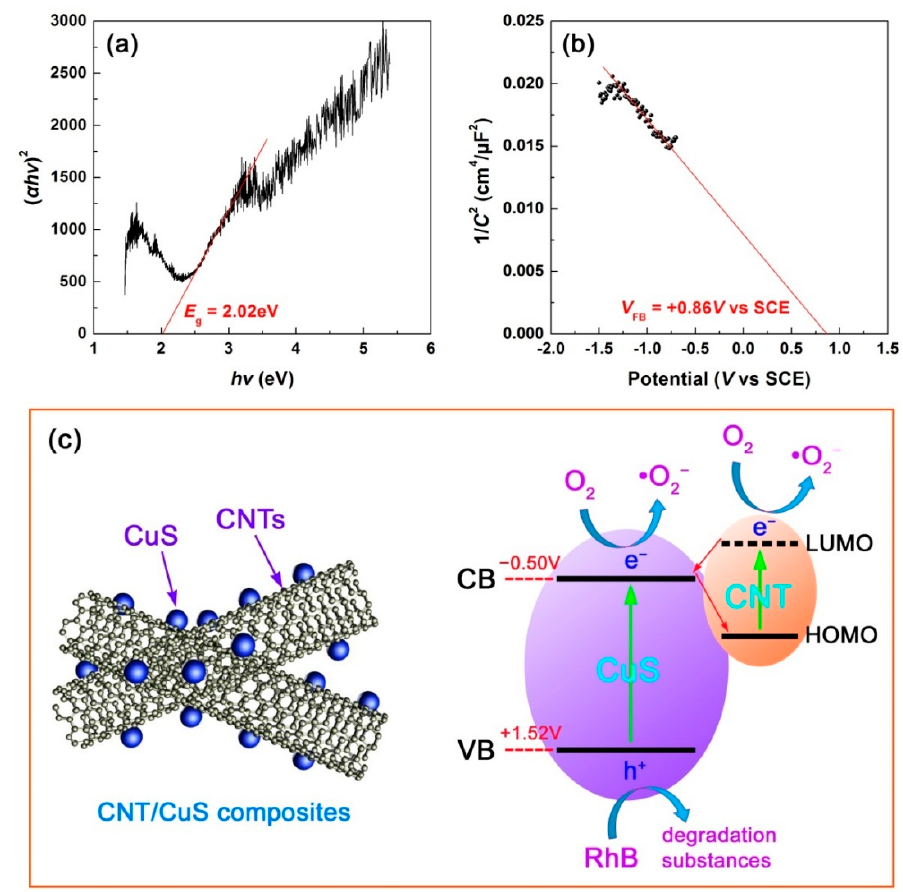
Figure 12. ( a ) Tauc plot of ( α h ν ) 2 vs. h ν for CuS. ( b ) M-S plot of CuS measured at a given frequency of 5000 Hz. ( c ) Schematic illustration of photodegradation mechanism of the CNT/CuS composite photocatalysts.